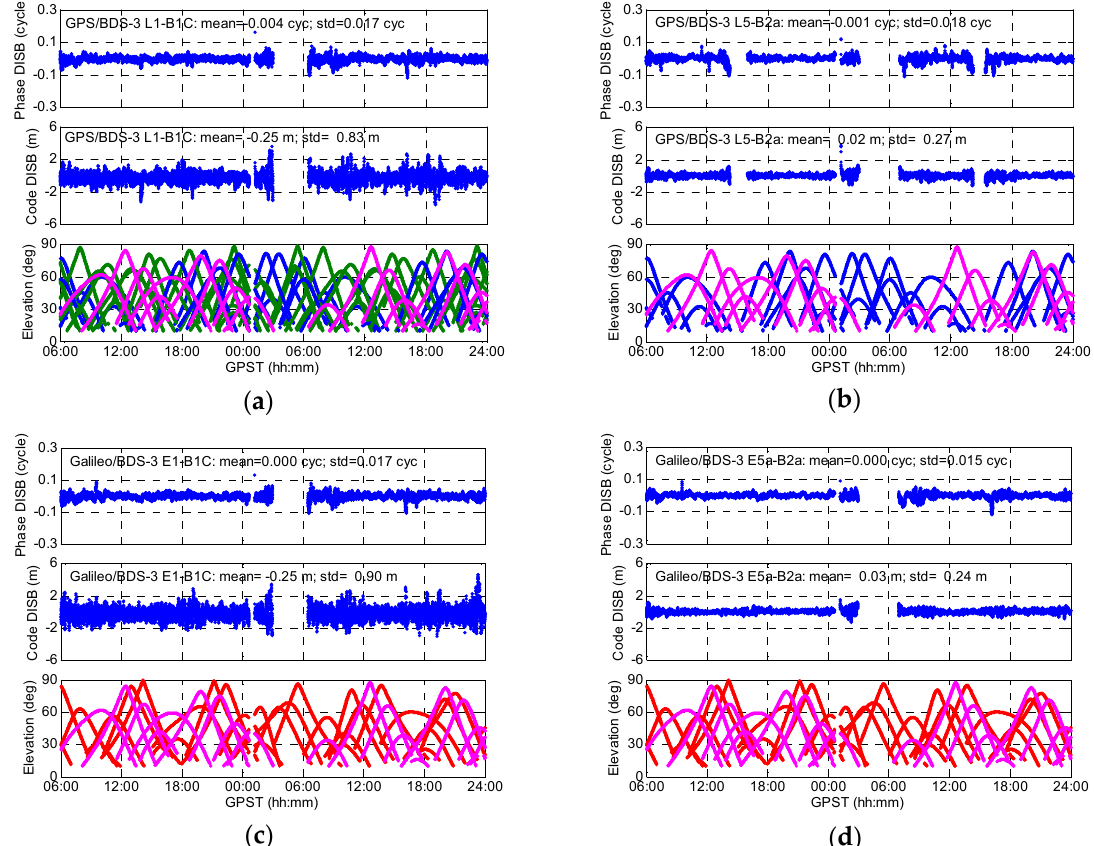
− 0.252 / 0 cycles and − 0.17 / − 89.65 m, respectively. Such results allow for calibrating and correcting these ISBs in advance.